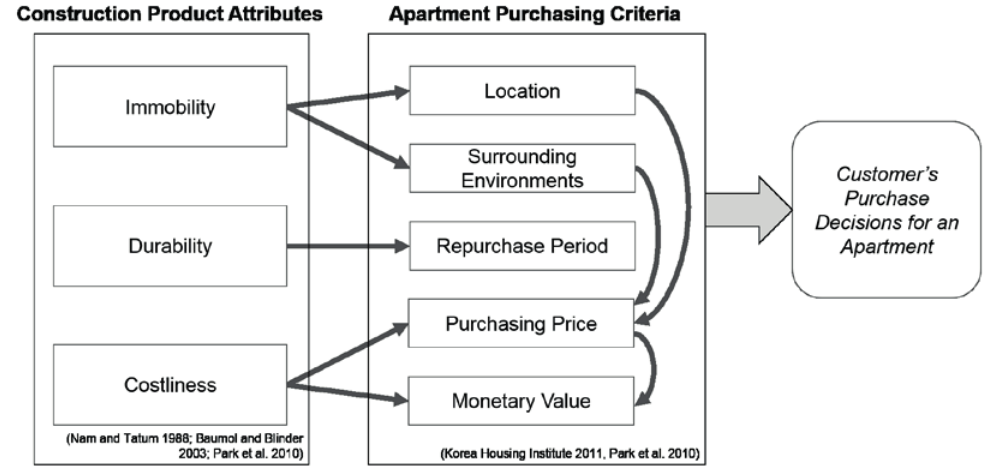
Fig. 1. Construction product attributes and apartment purchasing criteria